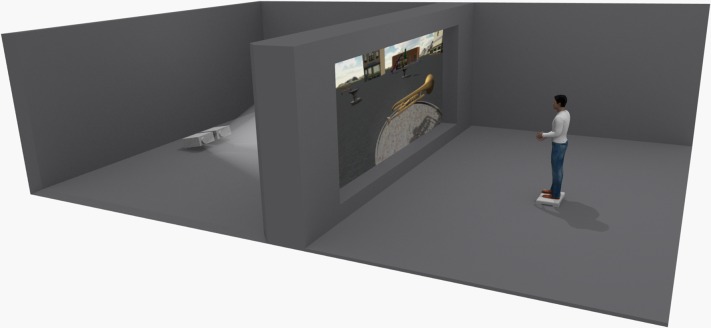
The testing room.